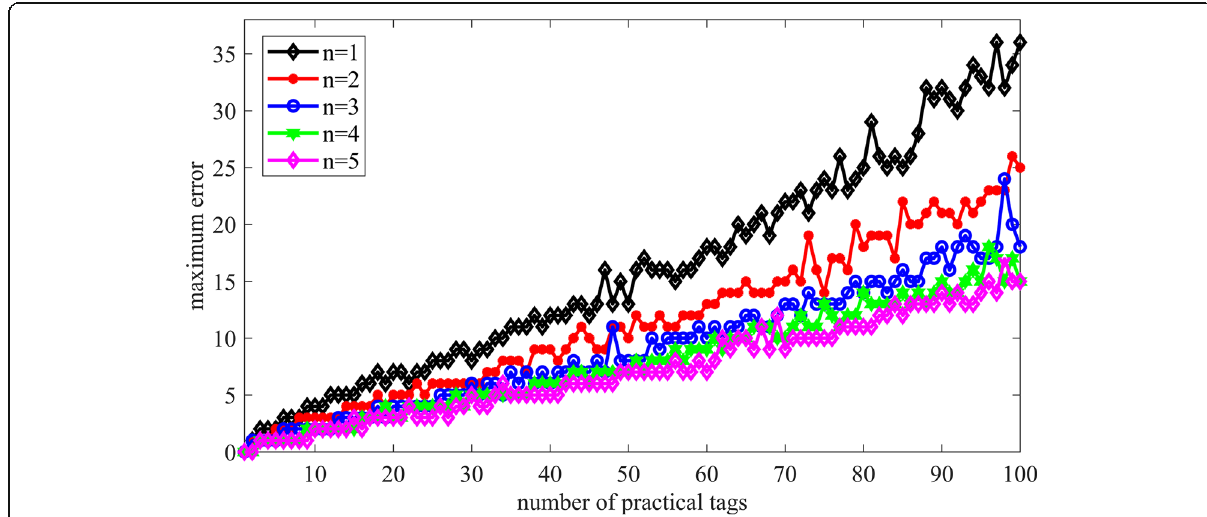
Fig. 7 Maximum errors for different